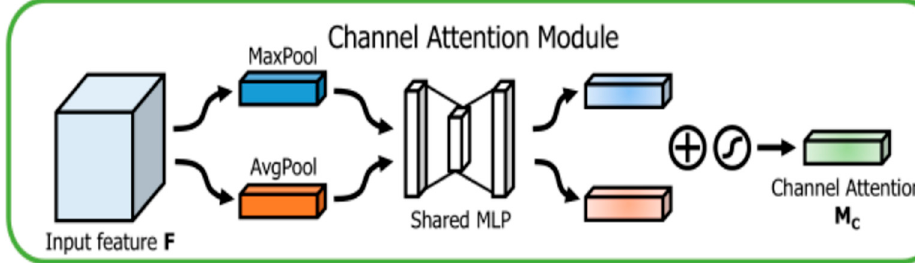
Figure 8. Channel attention mechanism.